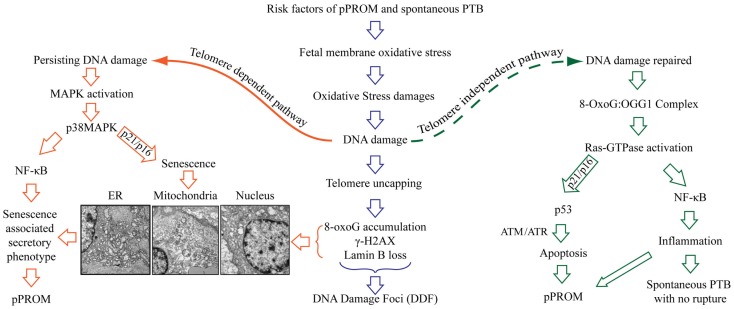
Oxidative stress-induced pathways of pPROM and spontaneous PTB with intact membranes. Risk factors of pPROM and PTB – like infection, obesity, poor nutrition, stress, behavioral risk factors (cigarette smoking, drinking, and drug abuse) – can cause oxidative stress (OS) in human fetal membranes that leads to OS-induced damages to all major cellular elements (lipids, proteins, and nucleic acid). Damages to DNA are especially lethal to fetal membranes and placental cells because they lead to oxidation of guanine base, resulting in mutagenic 8-OxoG formation. Telomeres are rich in G bases, and oxidation G bases lead to telomere attrition as a part of damage repair [base excision repair (BER)]. The pathway of pPROM and PTB may be delineated at this stage based on the type of risk and the type of OS response: overwhelming OS (chronic OS with smoking, alcohol use, obesity, poor nutrition, etc.) vs. infection/inflammation-related acute OS by fetal cells or immunocytes. Overwhelming OS can lead to persistent DNA damage and telomere reduction, 8-OxoG formation, resulting in DNA damage foci (DDF) formation. Telomere-dependent pathway – when OS is too high to be controlled by antioxidant mechanisms of the intrauterine tissues, especially fetal membranes, a telomere-dependent pathway arises where either OS itself or damaged DNA and other cellular elements can trigger p38MAPK activation either through NF-κB activation or direct cellular senescence. This is characterized by rounded, swollen organelles, and nuclear condensates. Additionally, senescing cells generate a unique set of biomarkers (senescence-associated secretory phenotype – SASP). SASP is characterized by cytokines, chemokines, matrix metalloproteinases, growth and angiogenic factors, and eicosanoids, all of which are involved in promoting labor. Telomere-independent pathway – in this pathway, oxidized Gs are excised from the damaged region by 8-oxoguanine glycosylase (OGG1) as a part of BER. 8-OxoG:OGG1 complex then activates Ras-GTPase and either promotes p53-mediated apoptosis or NF-κB-mediated inflammation. The exact mechanism of this switch is still unclear. Apoptosis is previously linked to pPROM. The latter pathway of NF-κB-mediated inflammation can be linked mostly to PTB with intact membranes.